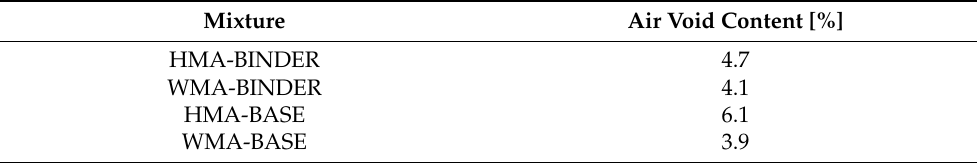
Table 1. Air void content of the mixtures.